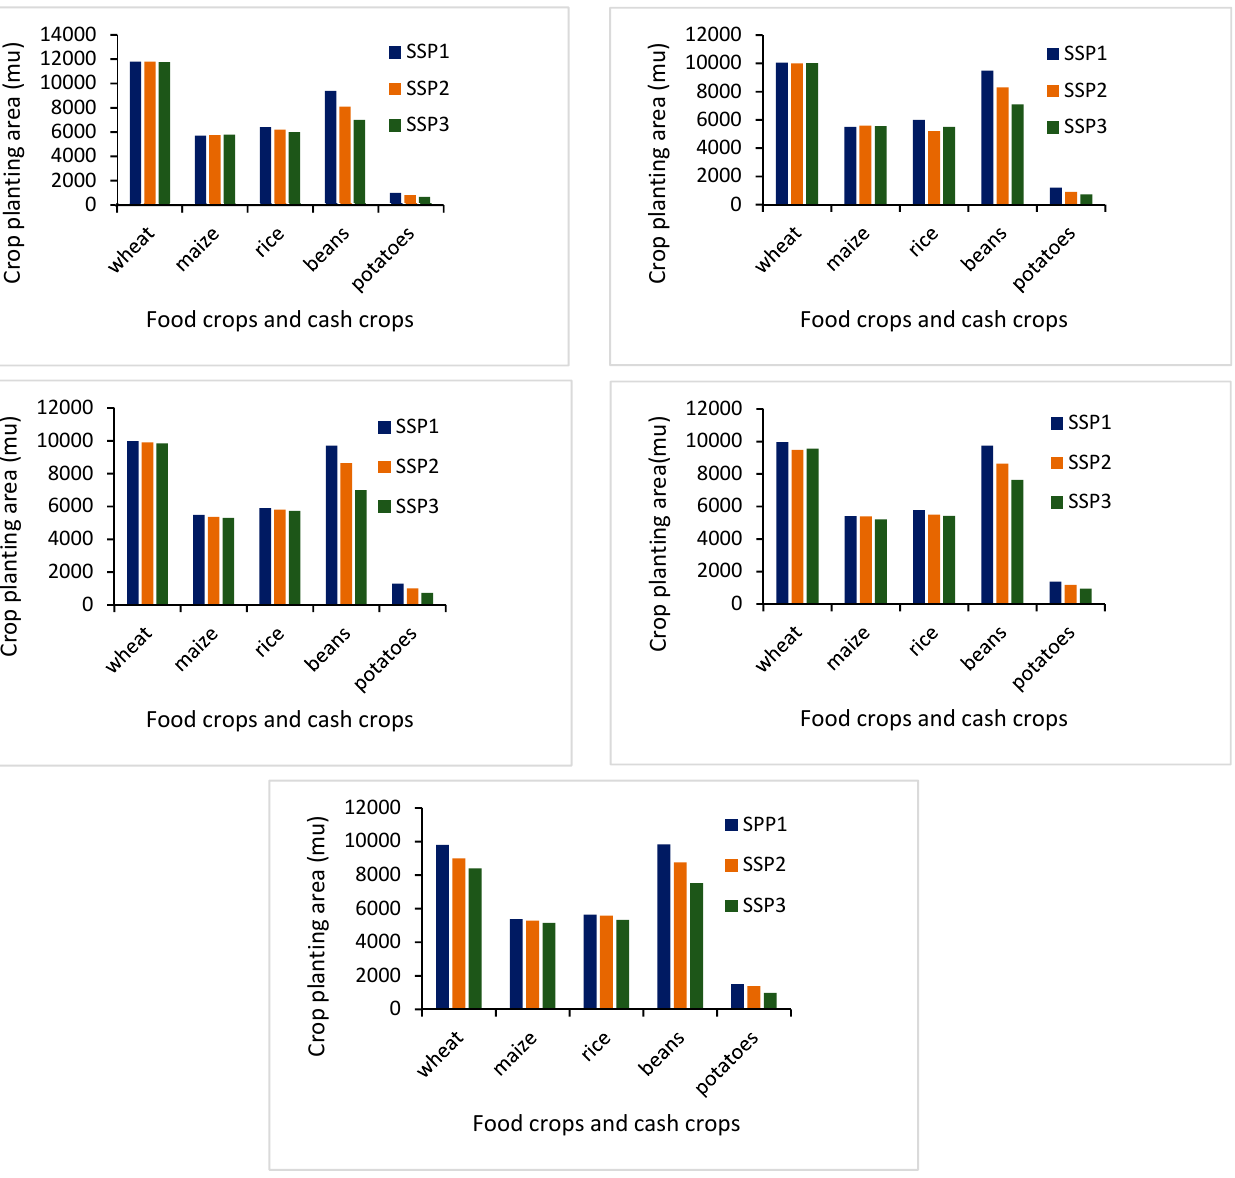
Figure 4. Planting areas for different crops in 2021–2025 under different SSPs.